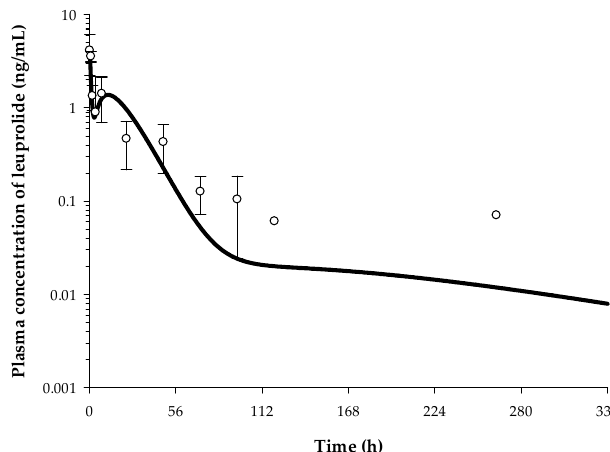
Figure 6. Plasma concentration–time profile described by the IVIVC-PK (pharmacokinetic) model. ( A ) The observed PK profile of Lucrin depot ® and the predicted PK profiles of five electrosprayed microsphere preparations. Closed circles refer to observational value after Lucrin depot Ⓡ administration. ( B ) The observed and the predicted PK profiles of OL5 ( n = 5). Open circles refer to the observed plasma concentration of leuprolide. Solid line indicates the model predicted PK profile.